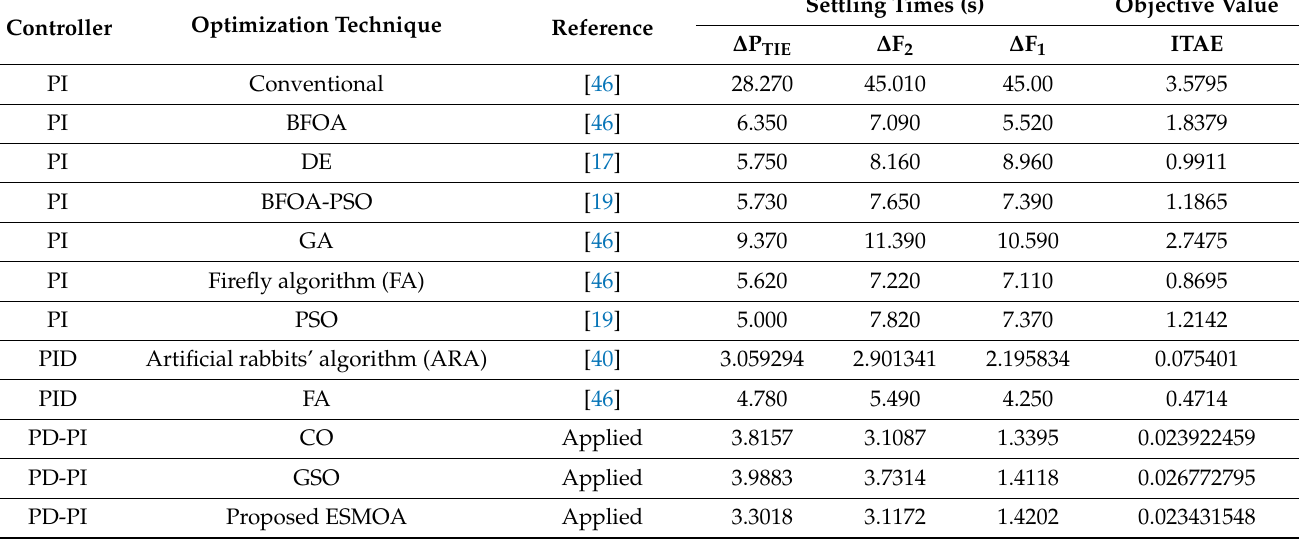
Table 4. Comparison of the proposed ESMOA outcomes with other reported results in terms of ITAE and settling time.